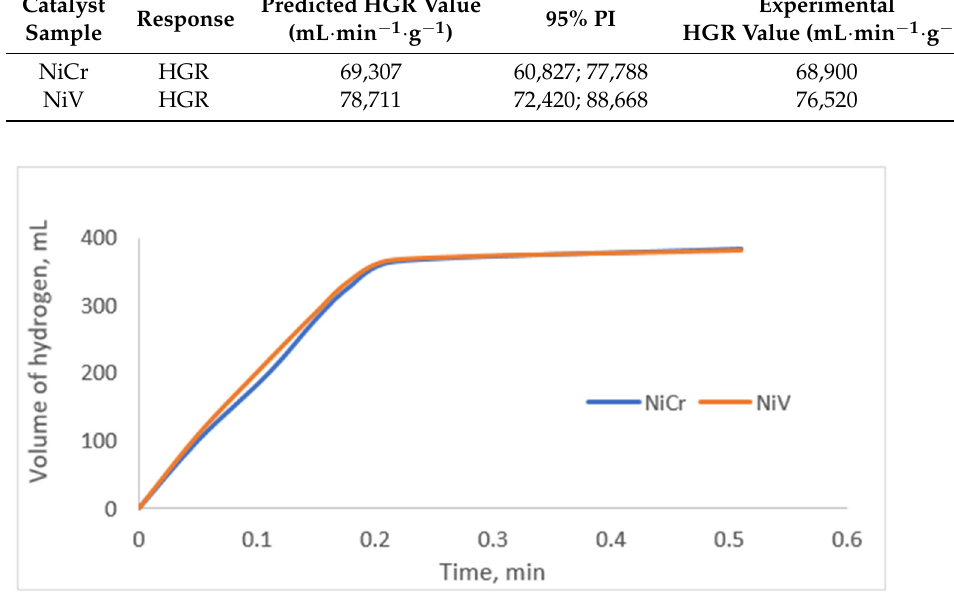
Figure 7. Graph of generated hydrogen volume versus time (1.65 g of catalyst, 6% KBH 4 , 3% NaOH, and 7 mL of 0.5 M HCl at 333 K).